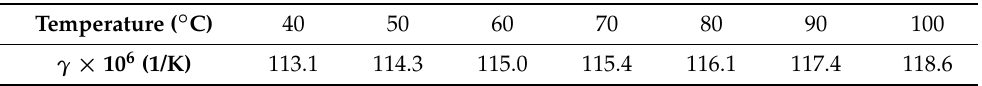
Table 2. The Cubic Expansion Coefficients of